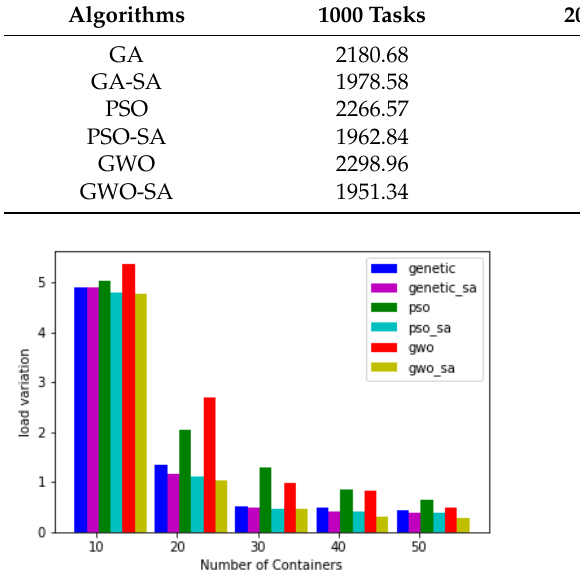
Figure 8. Load variation with 1000